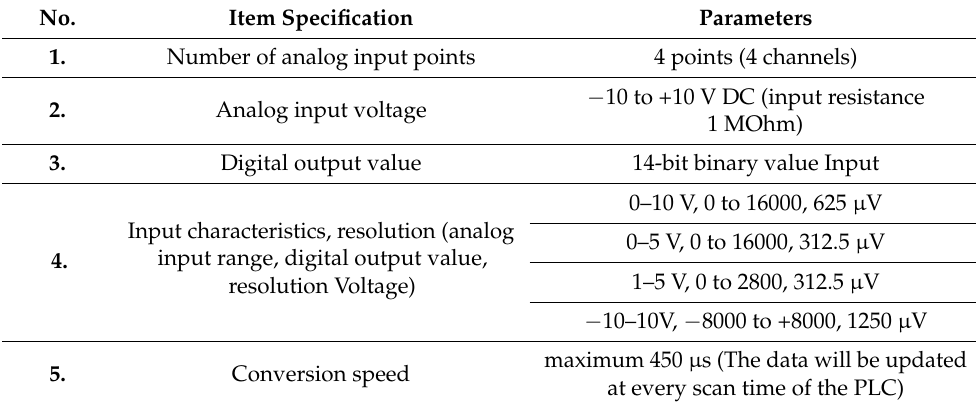
Table 2. The basic specification of the FX5-4AD-ADP analog input